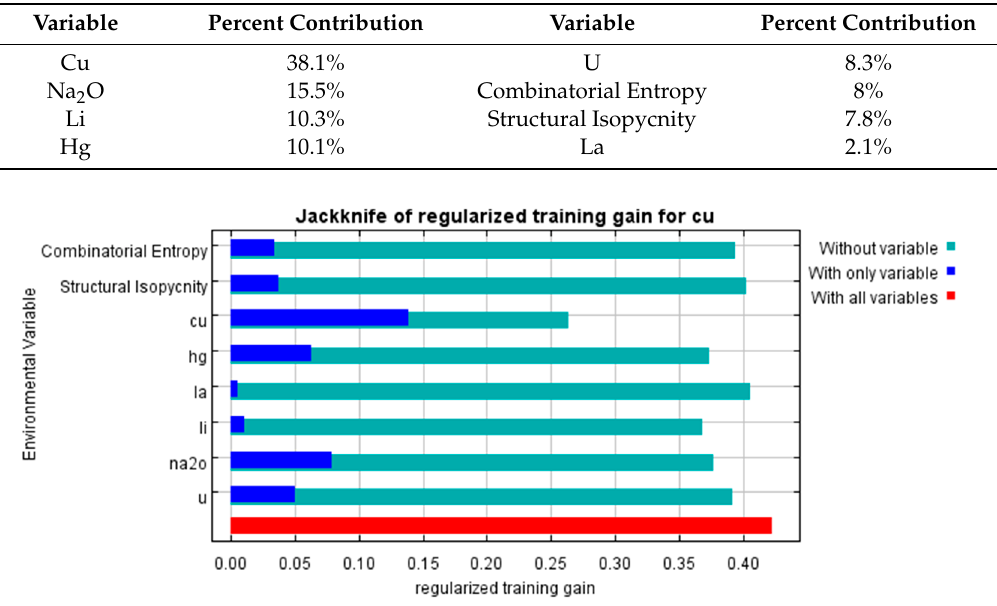
Figure 9. Jackknife analysis of the individual importance of ore-controlling factors in the MaxEnt model (the green bars show the performance of the global model without each variable; the blue bars show the influence of each variable in isolation; the red bar represents the model results using all variables).